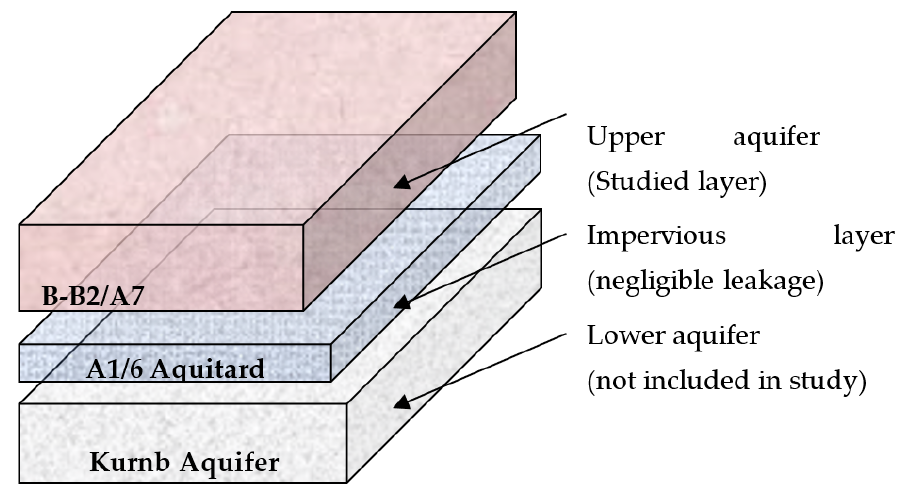
Figure 3. Conceptual model of the study area.